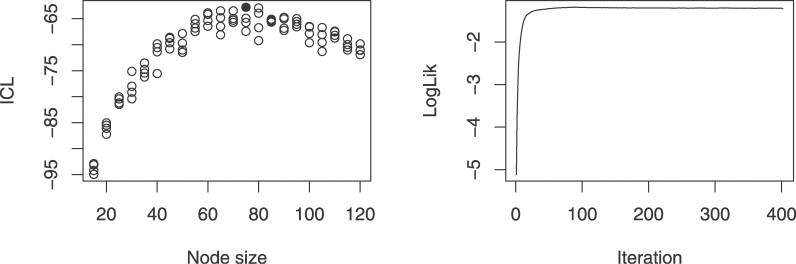
Training FB5–HMM(Left) ICL plotted versus hidden node size. For each hidden node size, four models were trained. The ICL reaches a maximum for one of the models with a hidden node size of 75 (indicated with a solid dot).(Right) Evolution of the LogLik of the completed data during training. The LogLik is plotted against the number of EM iterations.